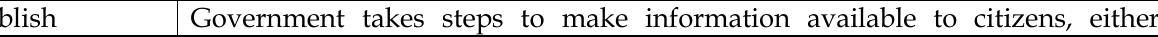
Table 1: Modes of Civic Interaction in an Open Government Context